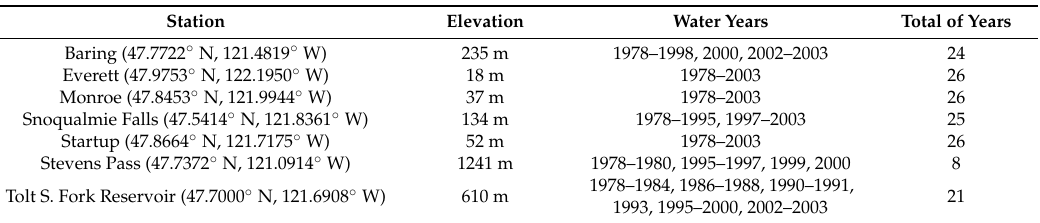
Figure 2. The Snohomish watershed (blue lines) and the location of the USGS stream gauge near Monroe, WA, USA. Table 1. The NOAA Daily Precipitation Sites. Only calendar years with at least 300 recorded days were included in the